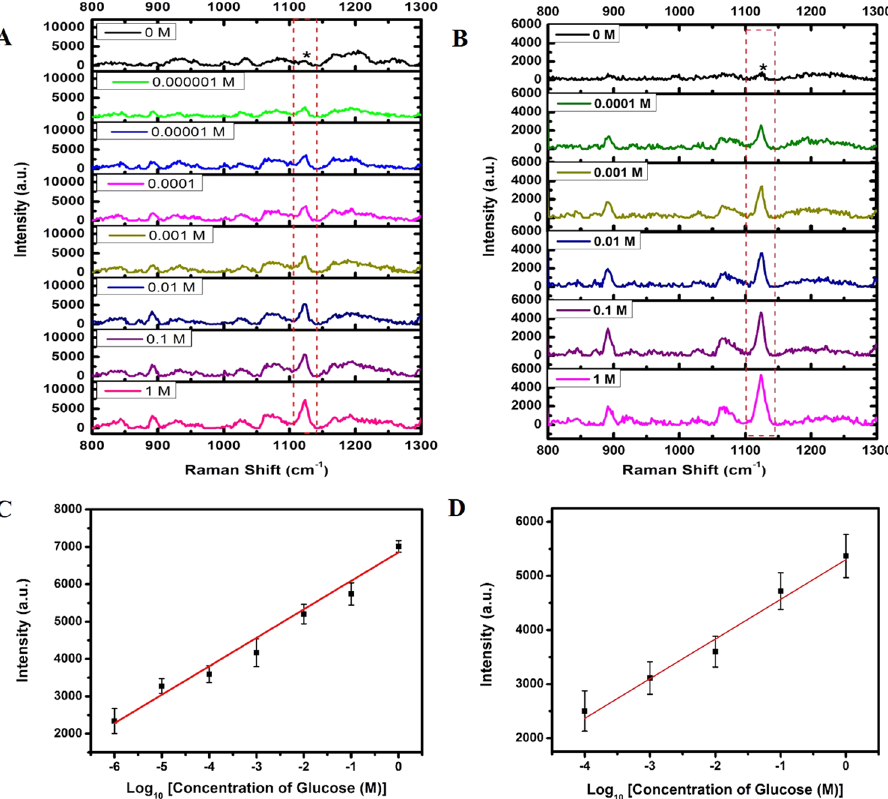
Figure 5. Representative SERS spectra of the aqueous glucose solution mixed with dried 1-DT-modified ( A ) Ag NP@N-GQD (freshly made) and ( B ) Ag NPs (freshly made) on the surface of a clean aluminum foil, respectively. The excitation wavelength was 785 nm with a power density of 9.09 W/mm 2 and an exposure time of 5000 ms. SERS intensity for the peak at 1123 cm − 1 of the ( C ) Ag NP@N-GQD and ( D ) Ag NPs dependence on the concentration of glucose with the range of (10 − 6 to 1 M) and (10 − 4 to 1 M), respectively. Each data point represents the average value from five SERS spectra measured from different locations. Error bars indicate the standard